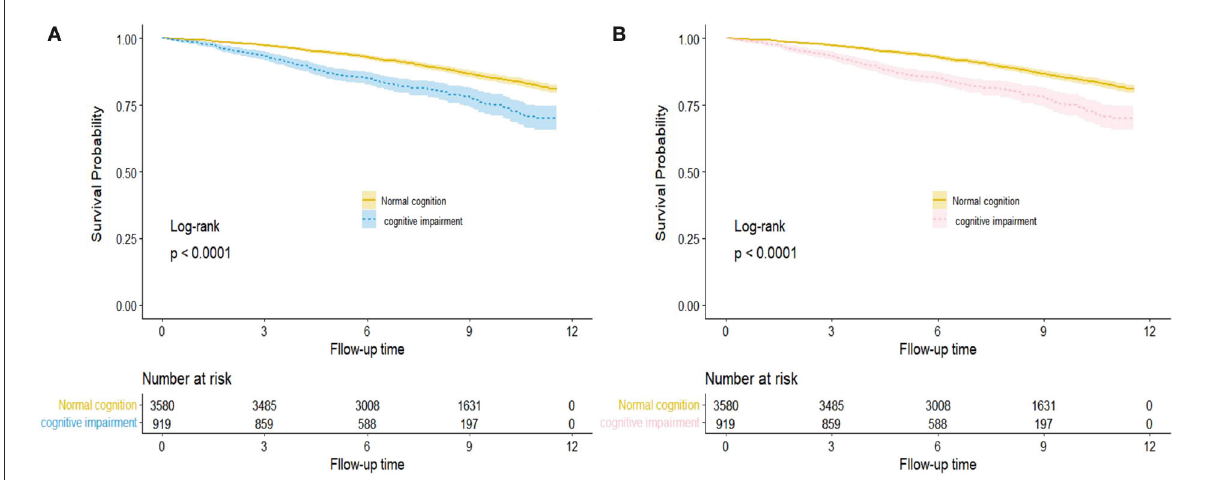
FIGURE1 Kaplan–Meier survival curve for hazard of all-cause (A) and CVD (B) mortality by cognition function status. The areas of shadow represent 95% CIs.